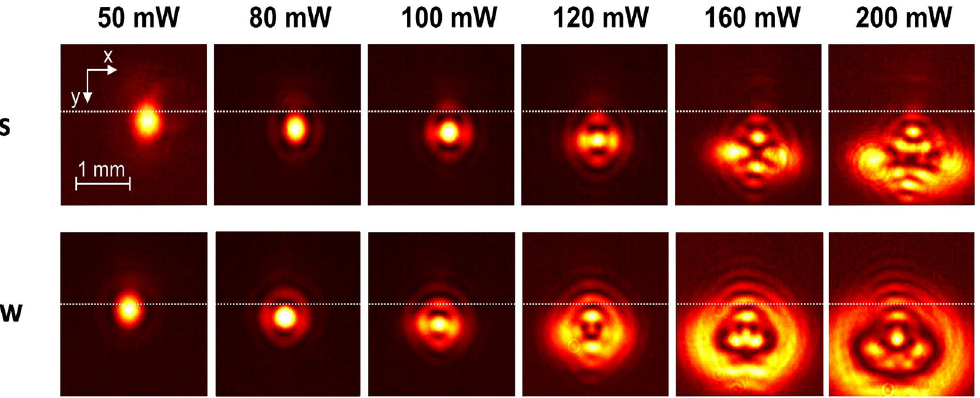
Figure 6: Far-field beam width profile under fs and cw excitation of sample S1 for high input powers recorded at position 1 and d = 15 mm. Beam pro fi le break-up effects are observed beyond 120 mW for both cases. Pronounced beam break-up is observed under cw excitation at lower input power and strong thermal blooming beyond 160 mW with a characteristic highly asymmetric lower half-portion. In the case of fs operation, a less asymmetric, yet complex pro fi le is observed. The downward displacement can be compared in the two cases with respect to the low-input-power position of the center of the beam (white horizontal